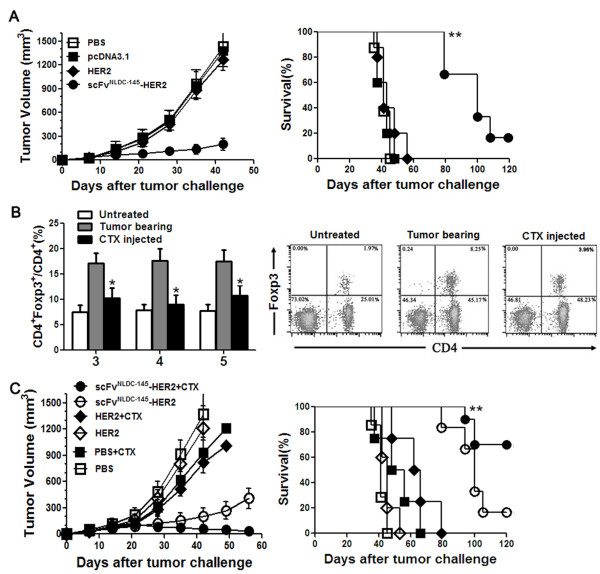
Therapeutic efficacy of scFvNLDC-145-HER2 vaccine. A BALB/c mice (10 mice per group) were inoculated s.c. with D2F2/E2 tumor cells. On day 7, animals with tumors sizing ~ 40 mm3 were immunized with scFvNLDC-145-HER2 or respective controls. Treatment was repeated on day 21. Tumor developments were monitored, and animal survival was calculated. Left panel, kinetics of tumor growth; Right panel, survival curve. The data were represented as the mean tumor volume (mm3) and representative of two experiments with comparable results. **, P < 0.01, scFvNLDC-145-HER2 compared with other groups. B temporary depletion of CD4+ Foxp3+ regulatory T cells by a single injection of low-dose CTX. BALB/c mice (3 mice per group) were inoculated s.c. with D2F2/E2 tumor cells. When the tumors were 3-4 mm in diameter (day 7), mice were injected i.p. with CTX (CTX injected) or PBS (Tumor bearing). Naive mice (Untreated) were used as control. The spleens were harvested at different time points and analyzed for the regulatory T cells. Left panel, Percentage of CD4+ Foxp3+ in total CD4+ cells; Right panel, a representative dot plot. Bars, SE. *, P < 0.05, CTX group compared with other groups. C BALB/c mice (10 mice per group) were inoculated s.c. with D2F2/E2 tumor cells. When the tumors were 3-4 mm in diameter (day 7), mice received CTX injection. Four days later (day 11), animals were vaccinated with various DNA vaccines. Treatment was repeated after two weeks. Left panel, kinetics of tumor growth; Right panel, survival curve. The data were represented as the mean tumor volume (mm3) and representative of two experiments with comparable results. **, P < 0.01, scFvNLDC-145-HER2/CTX compared with other groups.